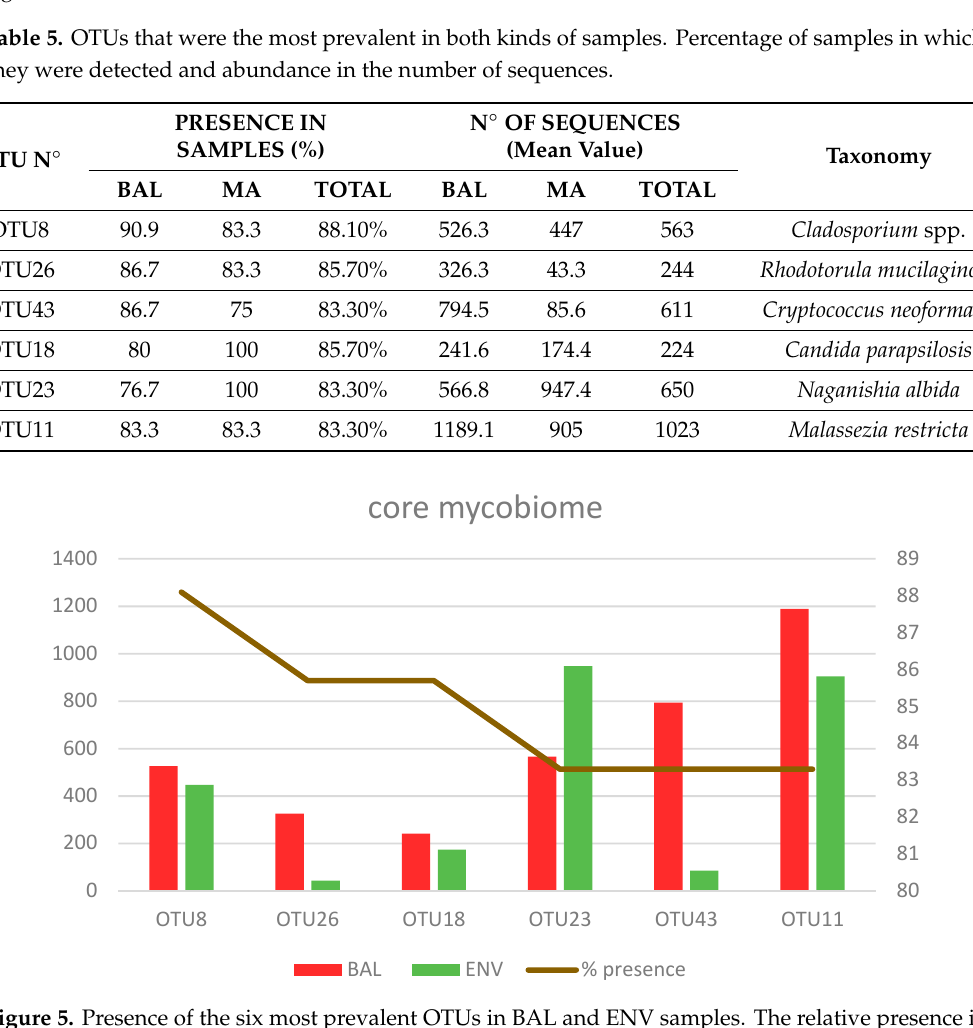
Figure 5. Presence of the six most prevalent OTUs in BAL and ENV samples. The relative presence is represented by the percentage of samples in which they were detected and the abundance as the mean value of sequences per sample.